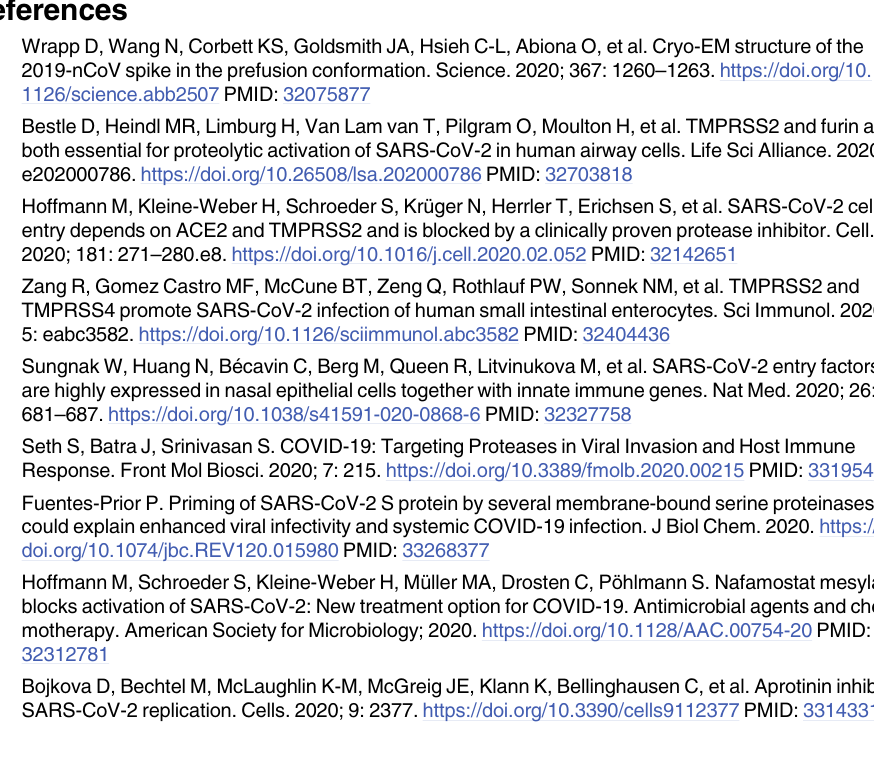
S3 Table. List of serine proteases related genes (SPRGs).